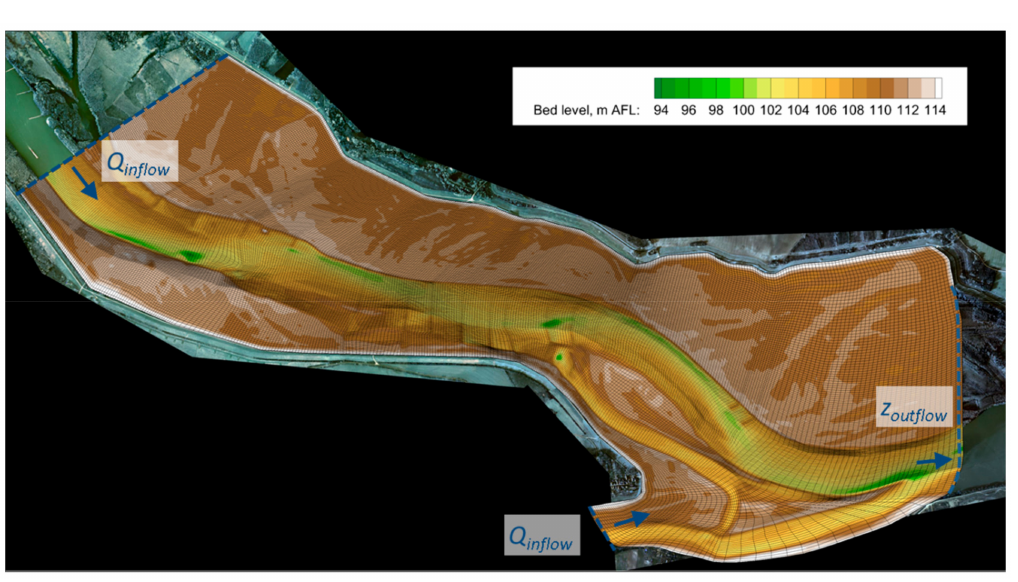
Figure 2. The computational grid of the investigated Danube study